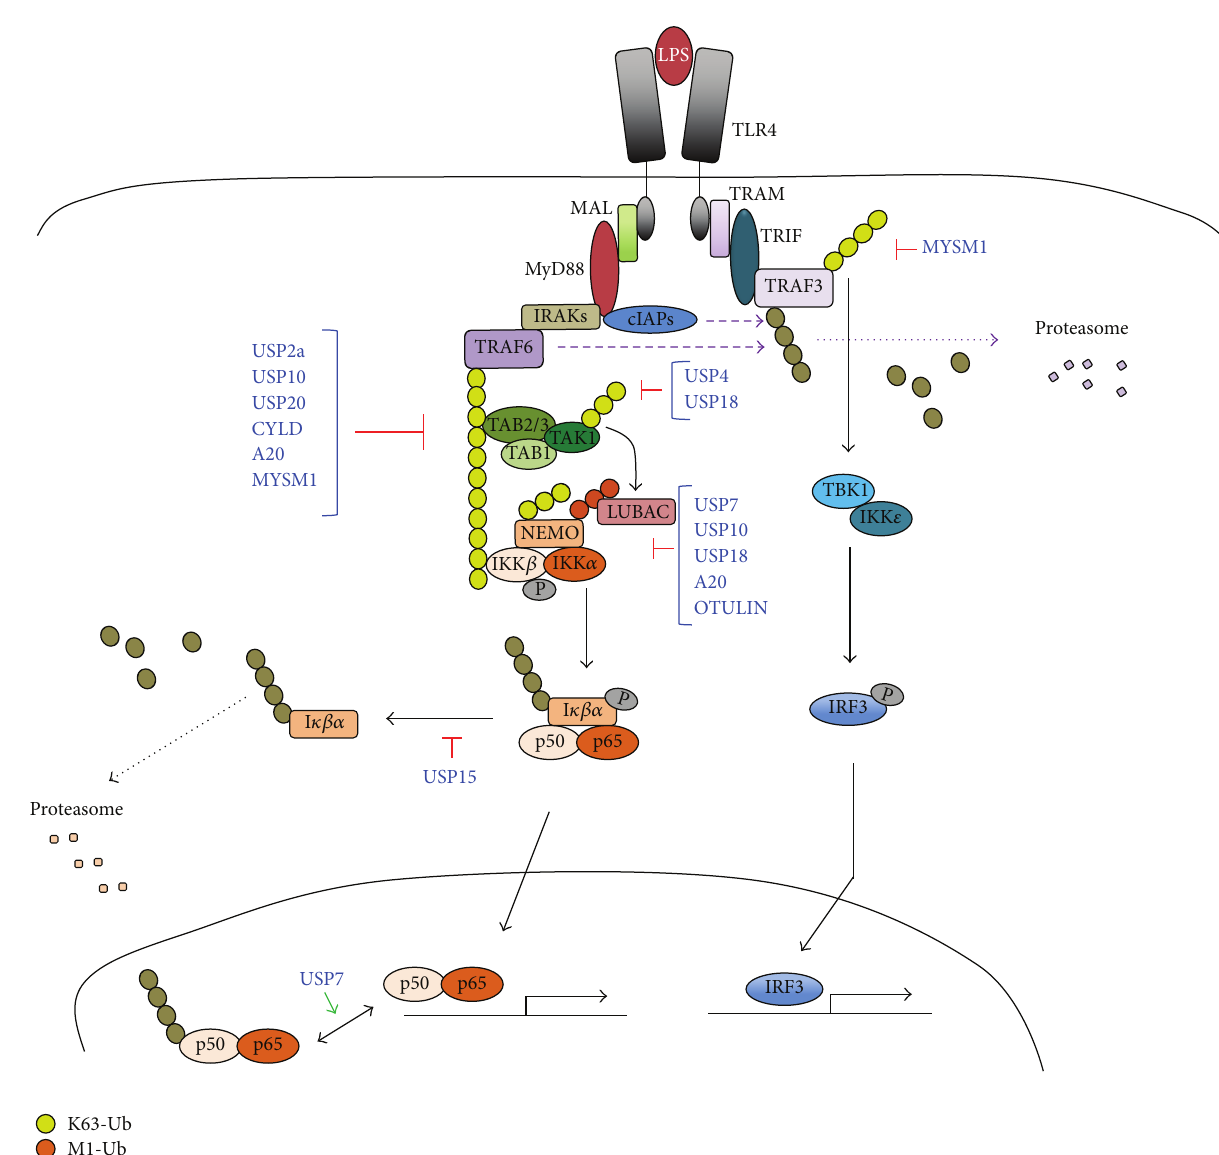
Figure 1: Regulation of TLR4 signalling by the ubiquitin-proteasome system. In MyD88-dependent signalling, TRAF6 and cIAP1/2s mediate K48 polyubiquitination and consequent degradation of TRAF3 by the proteasome. TRAF6 synthesizes K63 poly-Ub chains, which act as a scaffold for TAK1 and IKK complexes, TAB2/3 and NEMO. This occurs with the help of LUBAC, which leads to the linear ubiquitination of NEMO required for the recruitment of the IKK complex (IKK 𝛼 and IKK 𝛽 ). As a result, TAK1 phosphorylates IKK 𝛽 , which in turn phosphorylatesI 𝜅 Bandsubsequentlyundergoesubiquitinationandproteasomaldegradation.ThiseventfreesNF- 𝜅 B(p50/p65)totranslocate to the nucleus and initiate transcription. Several DUBs (in blue) remove ubiquitin chains from TRAF6, NEMO, or NF- 𝜅 B, negatively regulating this signalling pathway. USP7 can also prevent NF- 𝜅 B degradation hence positively regulating transcription. MyD88-independent signalling occurs through TRAM/TRIF. In this case K63 poly-Ub chains are added to TRAF3, which consequently recruits the TBK1/IKK 𝜀 kinasecomplex.ThisphosphorylatesIRF3allowingnucleartranslocationandinitiationoftranscription.TheDUBMYSM1candeubiquitinate TRAF3, controlling the extent of this